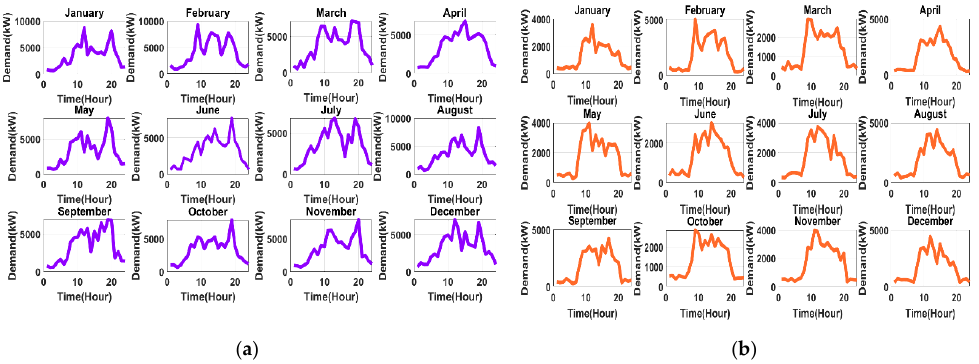
Figure 17. Impact on NPC due to daily peak demand variation.